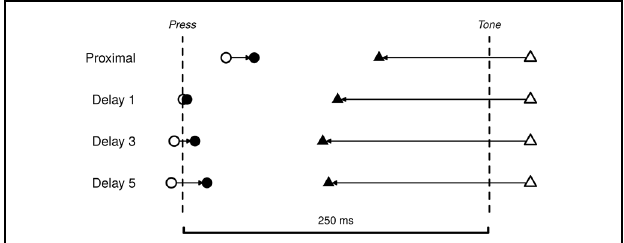
FIGURE 5 | Group level reported times of press and tone. Press is marked by circle and tone is marked by triangles. Open symbols indicate baseline conditions and solid symbols indicate operant conditions. Arrows indicate the shift from the baselines to the operant conditions that define the binding effect. The vertical dashed lines are the actual occurrence of press and tone 250 ms